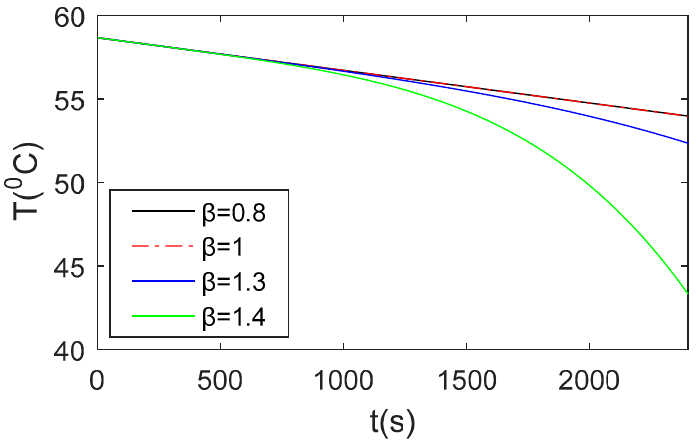
Figure 5. Pipeline temperature at different fractional-order β = 0.8, 1, 1.3, 1.4 ( λ = 2.8).